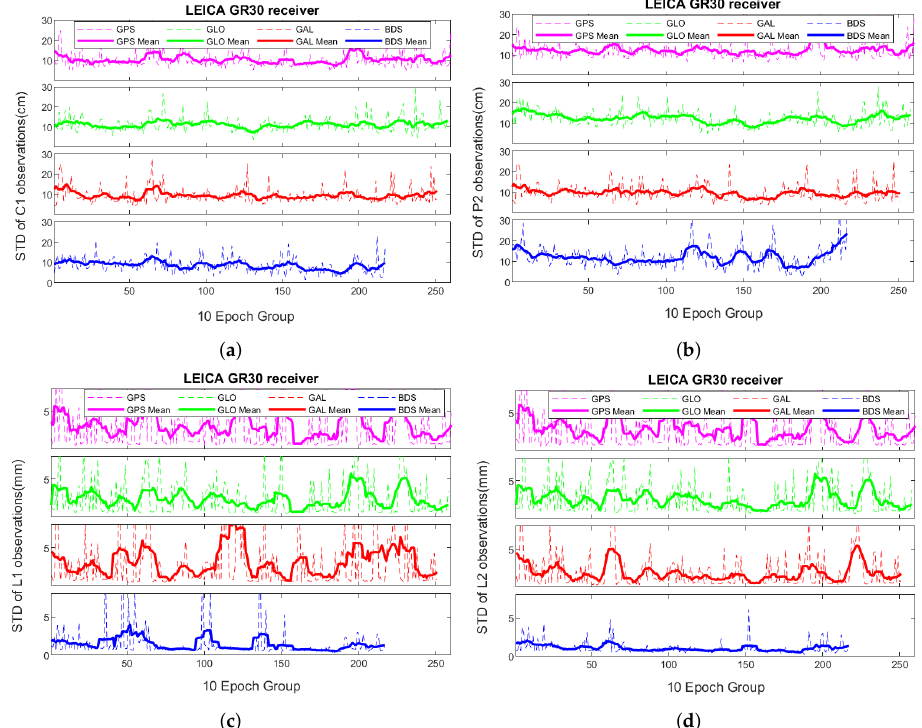
Figure 4. Groupwise estimated standard deviations for each system (dashed line) with their average values in 10 epoch group windows (bold line) over a very short baseline with LEICA GR30 receiver: ( a , b ) for the C1 and P2 in cm; ( c , d ) for the L1 and L2 in